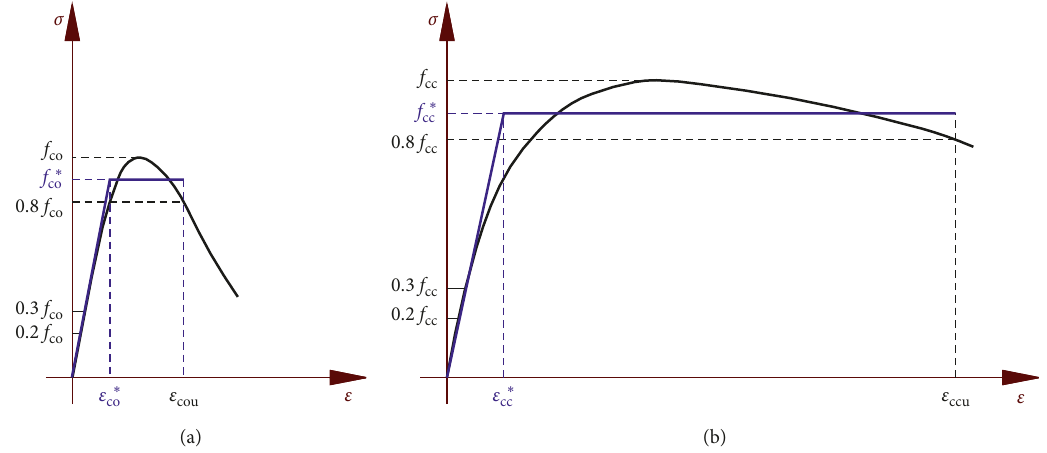
Figure 2: Definition of the ductility ratio. (a) Unconfined columns. (b) Confined